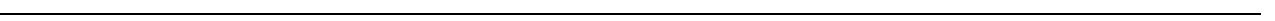
Fig. 1 PCGF5 loss-of-function blocks mESC neural differentiation. a Gene expression analysis of epigenetic factors in human embryonic stem cells (H1) and human neural stem cells (NSCs), respectively ( n = 3). Results are shown relative to H1. b Schematic overview depicting the targeting strategy for the Pcgf5 locus using TALENs (PGK/PN: donor indicates that containing a loxP- fl anked PGK-puromycin cassette and loxp- fl anked PGK-neomycin cassette. PGK human phophoglycerol kinase promoter, P puromycin resistance gene, N neomycin resistance gene). c Western blot and qRT-PCR analysis of PCGF5 expression in wild type and Pcgf5 − / − mESCs. Results are shown relative to wild type ( n = 3). d Western blot analysis of PCGF5, NANOG and OCT4 expression in wild type and Pcgf5 − / − mESCs. e Heatmap illustrating the expression of selected neurectoderm genes and mESC-speci fi c genes that were shown as log2 FPKM in wild type and Pcgf5 − / − mESCs at day 6 after neural differentiation. Each lane corresponds to an independent biological sample. f GSEA pro fi les of the sets of neurectoderm genes and mESC-speci fi c genes. g Western blot analysis of PCGF5, pluripotent markers (OCT4, NANOG), neural markers (NESTIN, β -III-TUBULIN) in wild type and Pcgf5 − / − mESCs during neural differentiation of mESCs. h – m Gene expression analysis of Nestin , Sox1 , β -III-tubulin , Pcgf5 , Oct4 , Nanog , in wild type and Pcgf5 − / − mESCs during neural differentiation of mESCs ( n = 3). Results are shown relative to wild type at day 0. Data in a , c , h – m are represented as mean values ± s.d. with the indicated signi fi cance from Student ’ s t -test (*** p <